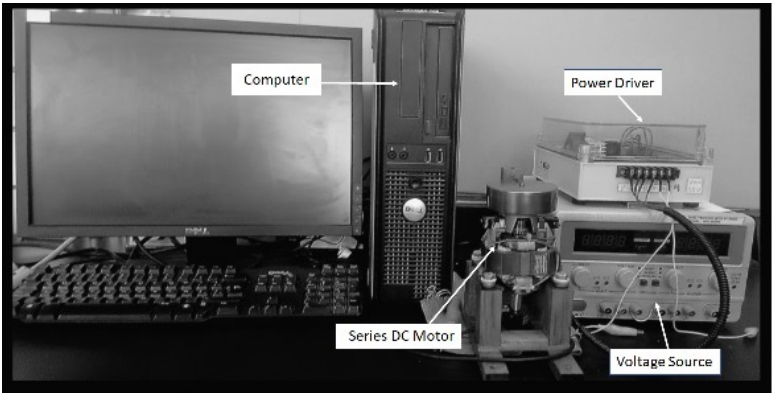
Figure 20. Experimental set-up.